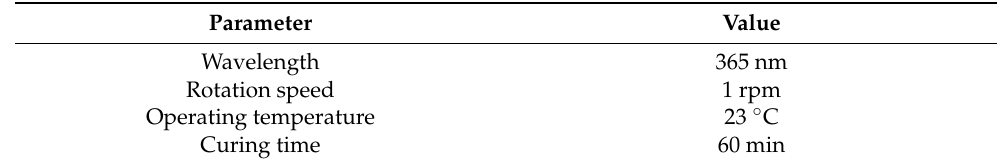
Table 3. The fixed and controlling factors of UV curing machine.